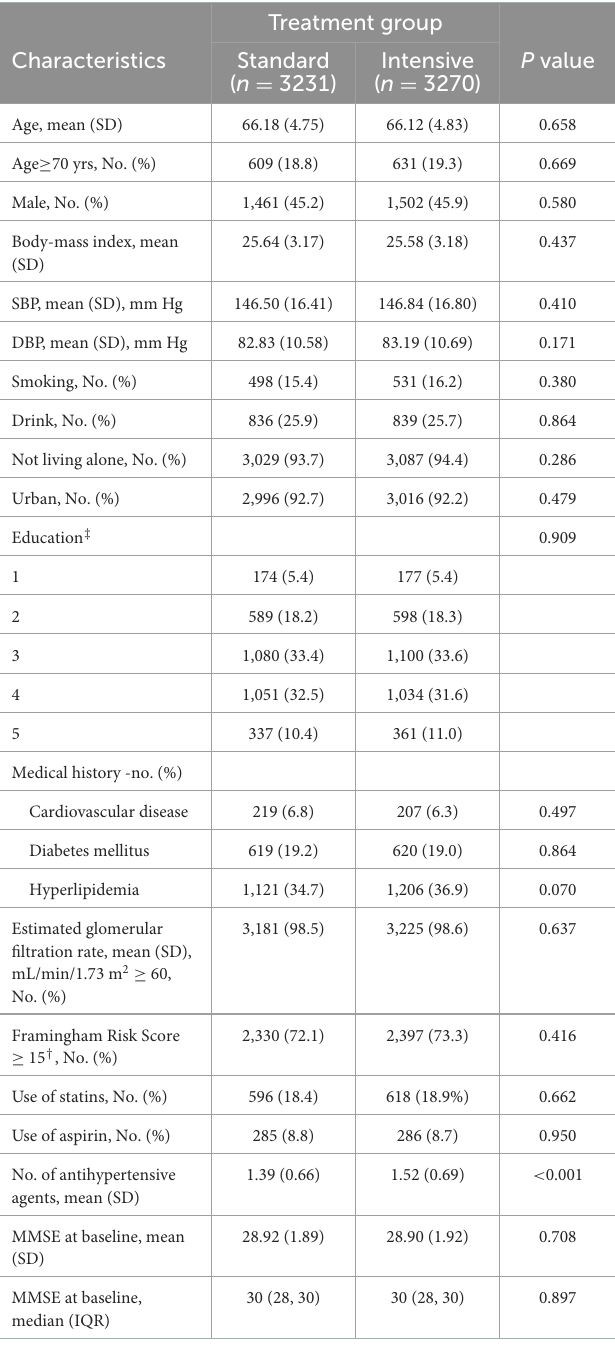
TABLE 1 Baseline characteristics of participants in this cognitive function analysis. Treatment